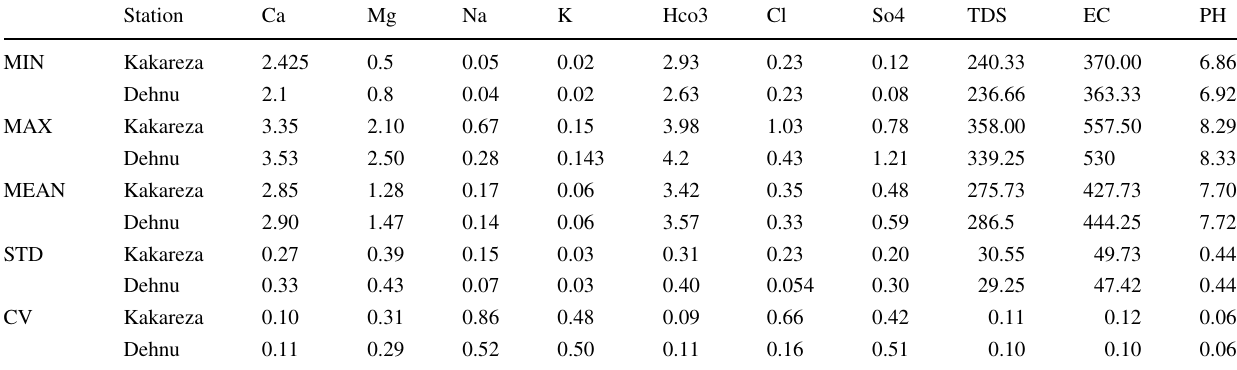
Table 2 Statistical parameter value of Kakareza and Dehnu hydrometry station